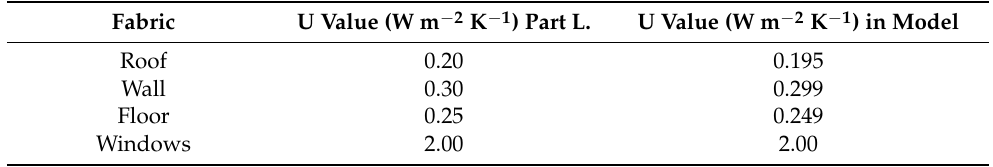
Table 5. Maximum U values required for new-build housing in England and used in model